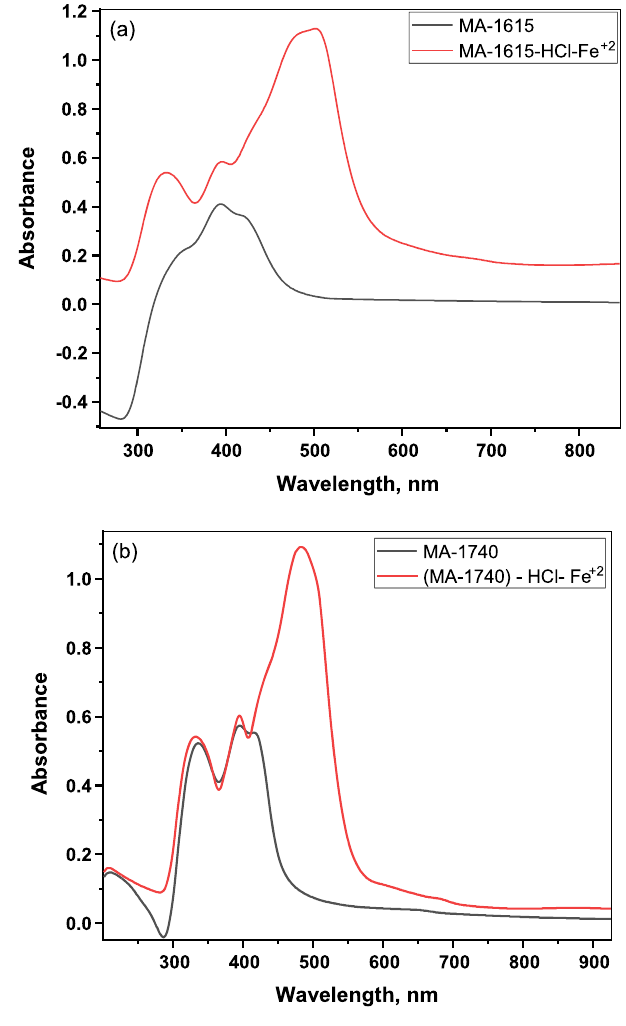
Figure 11. UV–visible electronic spectra of 500 µM of inhibitor MA-1615 ( a ) and inhibitor MA-1740 ( b ) before (black color) and (red color) after C-steel immersed in 500 µM HCl